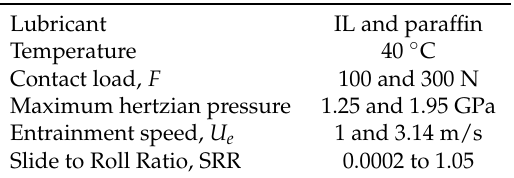
Table 1. Frictiontest